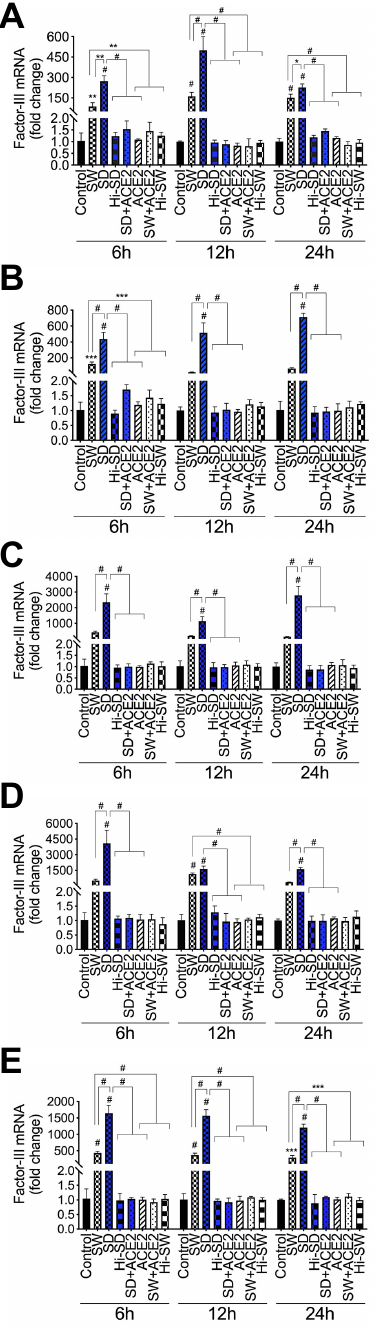
Figure 2. S-proteins and endothelial–neutrophil interactions induce Factor-III transcriptional upregula- Figure 2. S ‐ proteins and endothelial–neutrophil interactions induce Factor ‐ III transcriptional upreg ‐ tion in HLMEC and neutrophils. HLMEC were treated with 1 nM S-protein Wuhan (SW) or Delta (SD) ulation in HLMEC and neutrophils. HLMEC were treated with 1 nM S ‐ protein Wuhan (SW) or Delta (SD) variants for 6–24 h ( A ). In separate experiments, HLMEC were treated with S ‐ proteins for 6 h, variants for 6–24 h ( A ). In separate experiments, HLMEC were treated with S-proteins for 6 h, washed, and co-cultured with neutrophils for 6–24 h ( B , C ); neutrophils were treated with S-proteins for 6 h, washed, and co-cultured with HLMEC for 6–24 h ( D , E ). Each cell type was harvested separately and Factor-III mRNA levels in endothelial cells ( A , B , D ) and neutrophils ( C , E ) were quantified by real-time PCR. Data presented as mean ± standard deviation. Control: untreated cells; ACE2: cells treated with recombinant human ACE2 (1 µ g/mL). Hi: cells treated with heat-inactivated S-proteins. * p = 0.01; ** p = 0.002; *** p < 0.0008; # p <